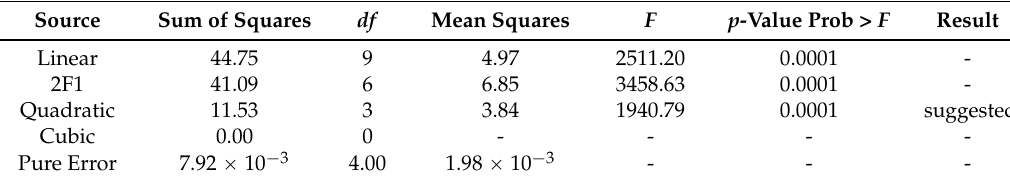
Table 5. Variance analysis of regression